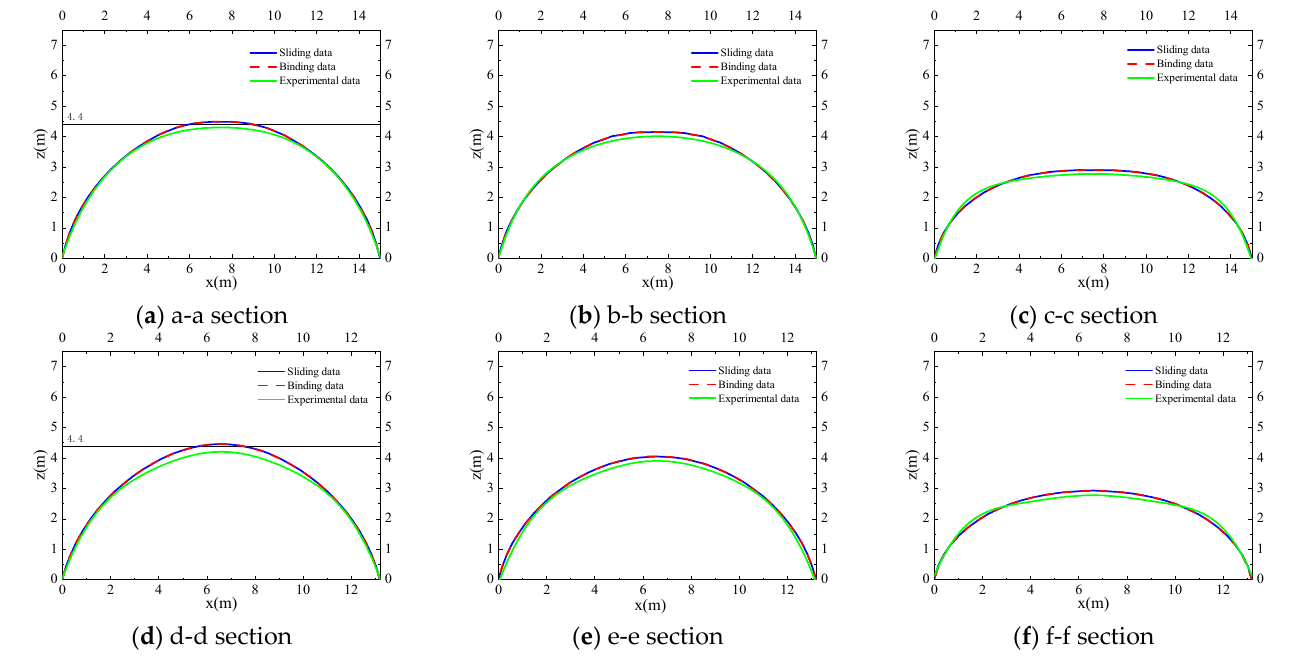
Figure 27. Comparison curve diagram of transverse